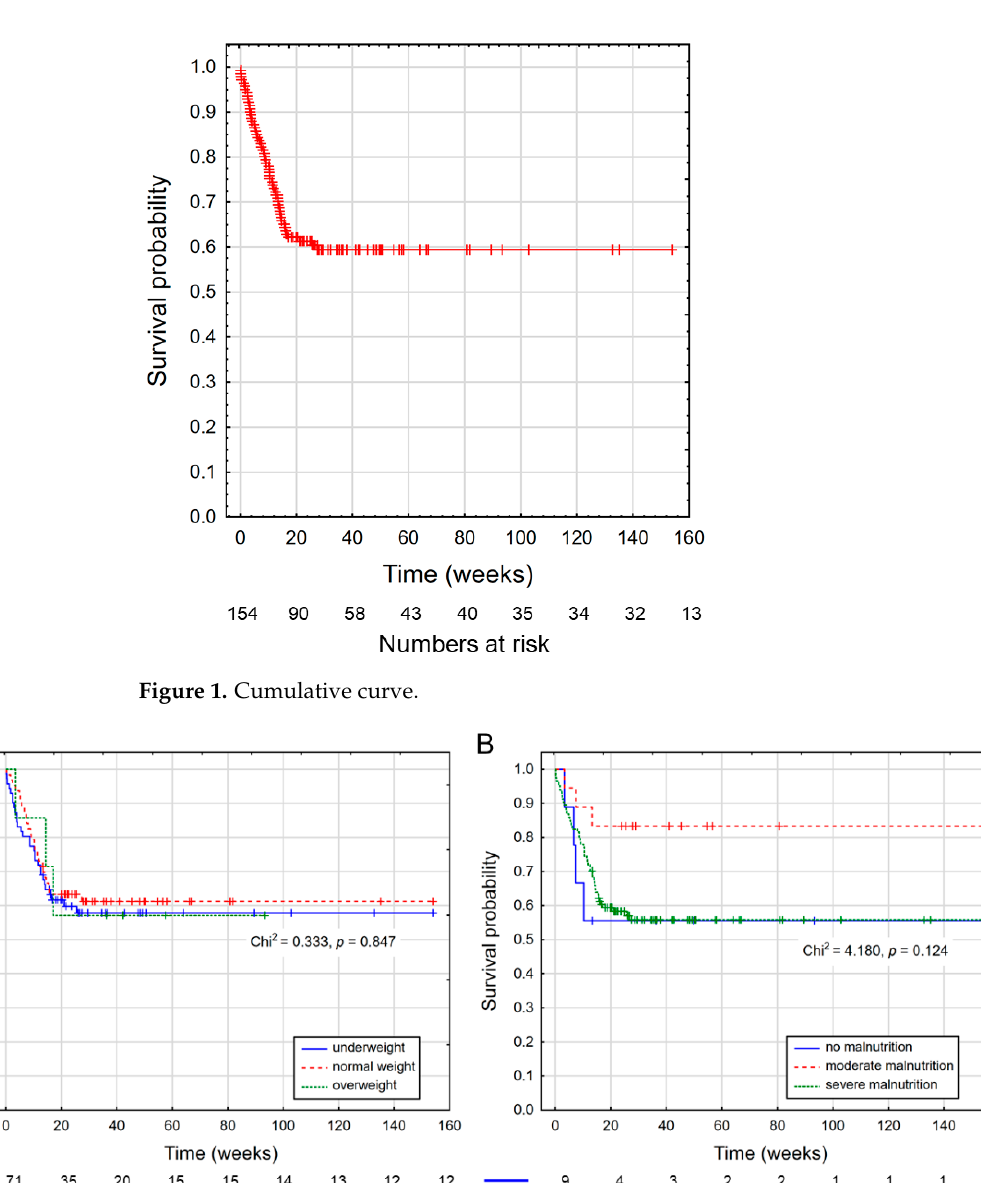
Figure 3. Survival curves ( A ) according to NRI; ( B ) according to GNRI. The results of multivariate Cox regression analysis showed that CRP level was positively related to the risk of death ( p < 0.001; HR = 1.015; 95% CI, 1.01–1.02). In case of BMI the results were as follows: p = 0.727 (95% CI, 0.91–1.14), for percentage of body weight loss: p = 0.532 (95% CI, 0.83–1.10), and for body weight loss in kilograms: p = 0.480 (95% CI, 0.78–1.11). The results of analysis for GLIM-defined no malnutrition vs moderate malnutrition showed the relationship but the strength of the result was weak ( p = 0.082, HR = 0.260, 95% CI, 0.06–1.20). There was no significant difference between no malnutrition and severe malnutrition ( p = 0.683, HR = 0.629, 95% CI, 0.18–2.22).